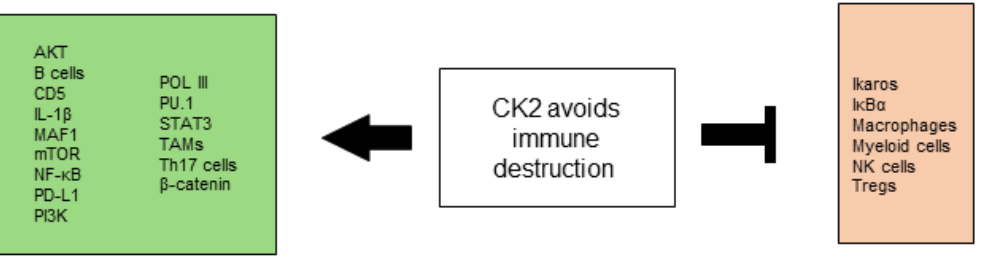
Figure 8. CK2-dependent modified proteins involved in the avoidance of immune destruction. Proteins that are activated in this process by CK2 modification are shown on the left (highlighted in green), and proteins that are restricted in their function are shown on the right (highlighted in red).